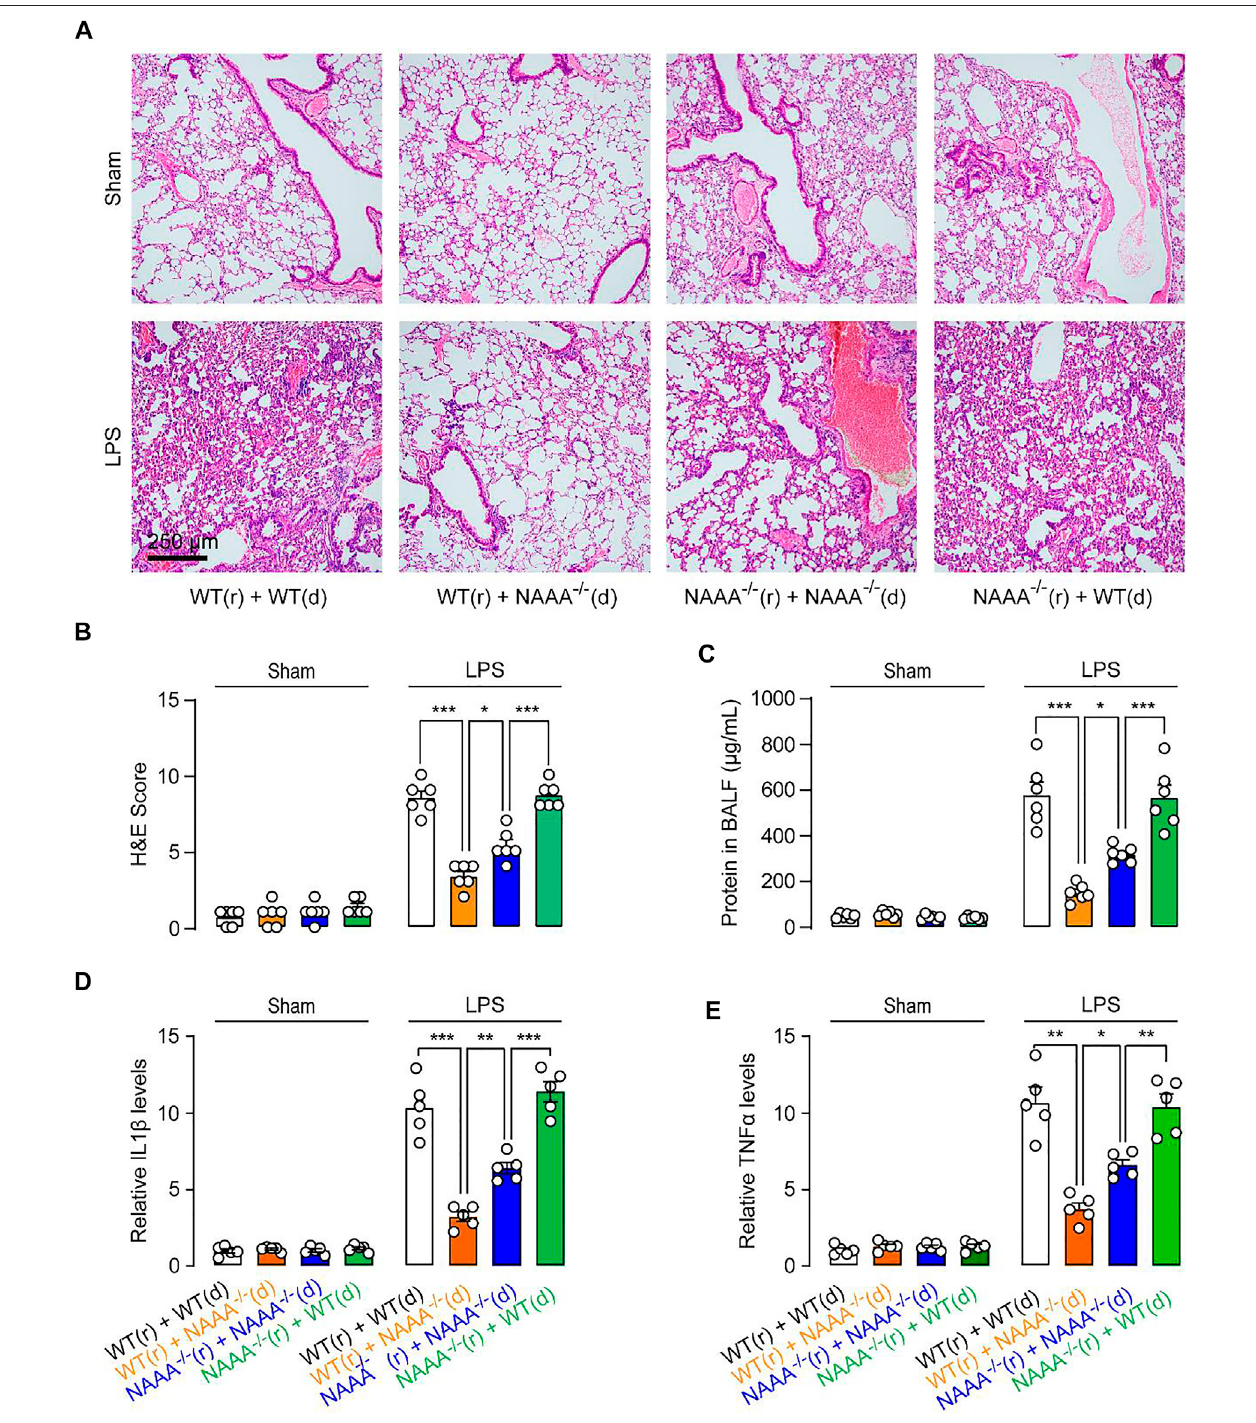
FIGURE5| GeneticblockadeofNAAAinnon-BMcellscauseanti-in fl ammatorytolerance.BMisolatedfromWT(d)orNAAA − /- (d)micewasindividuallytransferred intolethally irradiatedWT (r)orNAAA − /- (r)mice.Chimeraswereusedforstudies8weeksafterinitialreconstitution.Chimericmice wereinstilledintratracheallywithsaline or LPS, following by treatment with vehicle or F96 (30 mg/kg, i.v ., 6 h after LPS administration). (A,B) H&E staining lung sections of chimeras sacri fi ced 24 h after LPS administration. (C) ProteinconcentrationsinBALFinchimeras. (D) IL1 β and (E) TNF α mRNAlevelsinlungtissues.Dataareexpressed asmean ± SEM( n (cid:1) 5 – 6).*, p < 0.05; ***, p < 0.001 by one-way ANOVA.